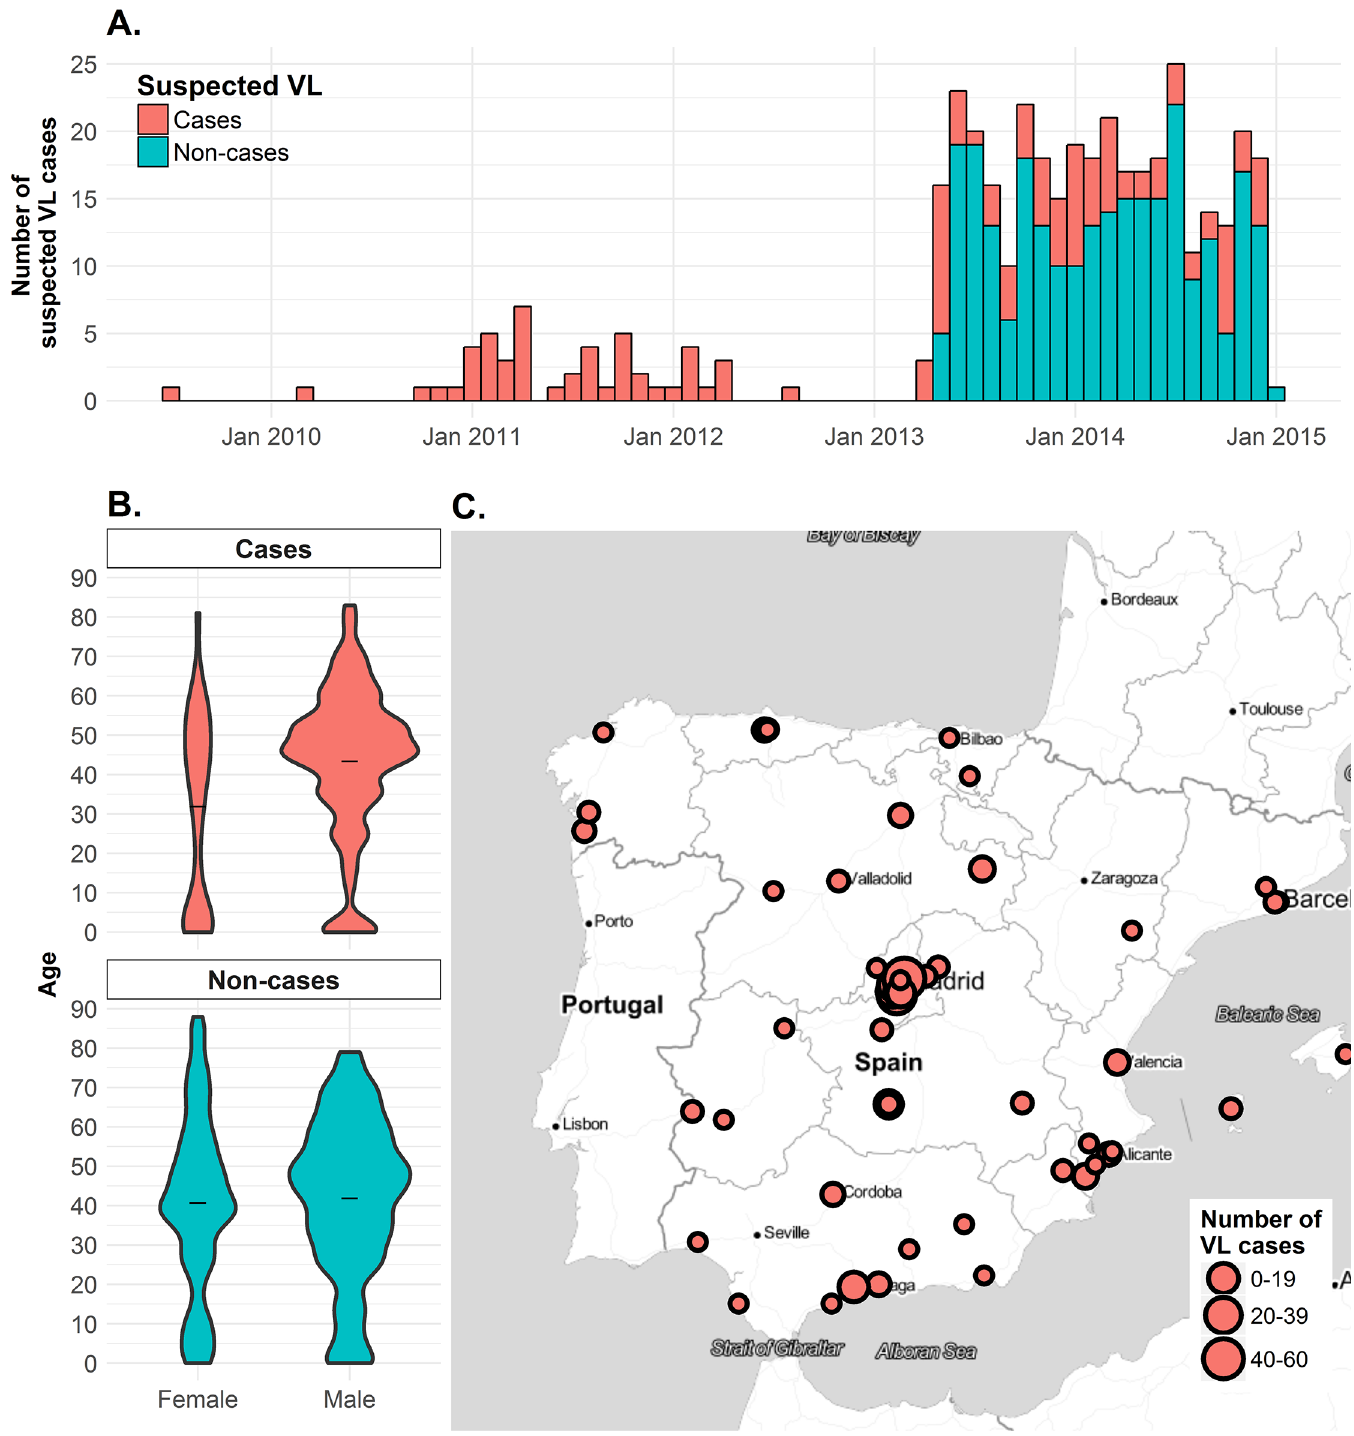
Fig 1. Timeline and demographics of suspected visceral leishmaniasis (VL) cases tested at the WHOCCL-ISCIII, Spain, 2009–2015. Panel A shows the number of VL cases and non-cases tested by month. Panel B shows the age and sex distribution of suspected VL cases and non-cases. Panel C maps the location of health centres in Spain where VL cases sought diagnosis (circles) and the number of VL cases per health centre (size of circle). Map tiles by Stamen Design, under CC BY 3.0. Data by OpenStreetMap, under ODbL.